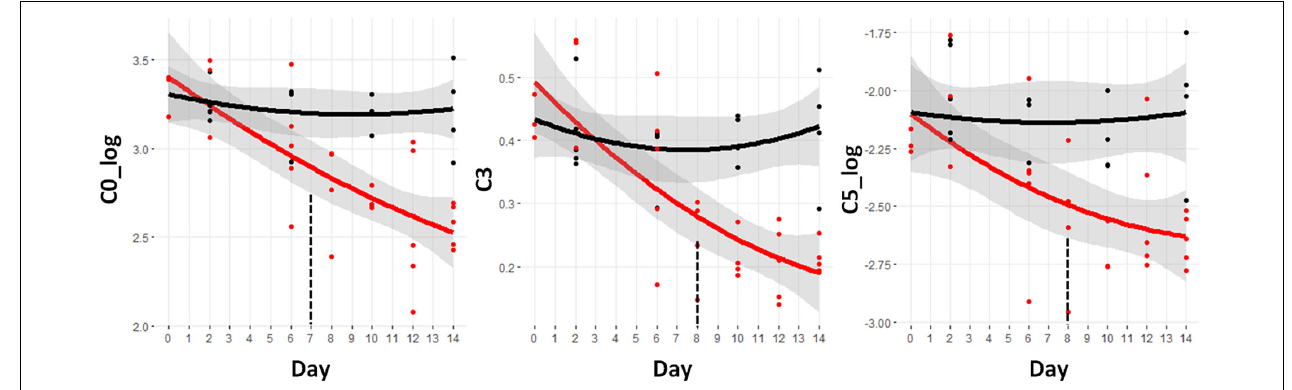
FIGURE 4 | Trajectory of acylcarnitine concentrations that were statistically significantly different prior to the observation of significant weight loss at day 9. Black indicates control mice, red indicates cachectic mice, and the vertical dashed lines indicate the day in which the data were first significantly different. C0, free carnitine; C3, propionyl carnitine; C5,